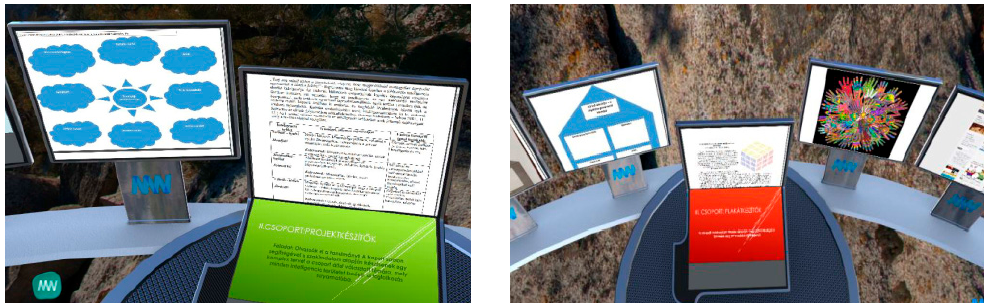
Figure 8. Two study “desks” with task description, helping the template and study.